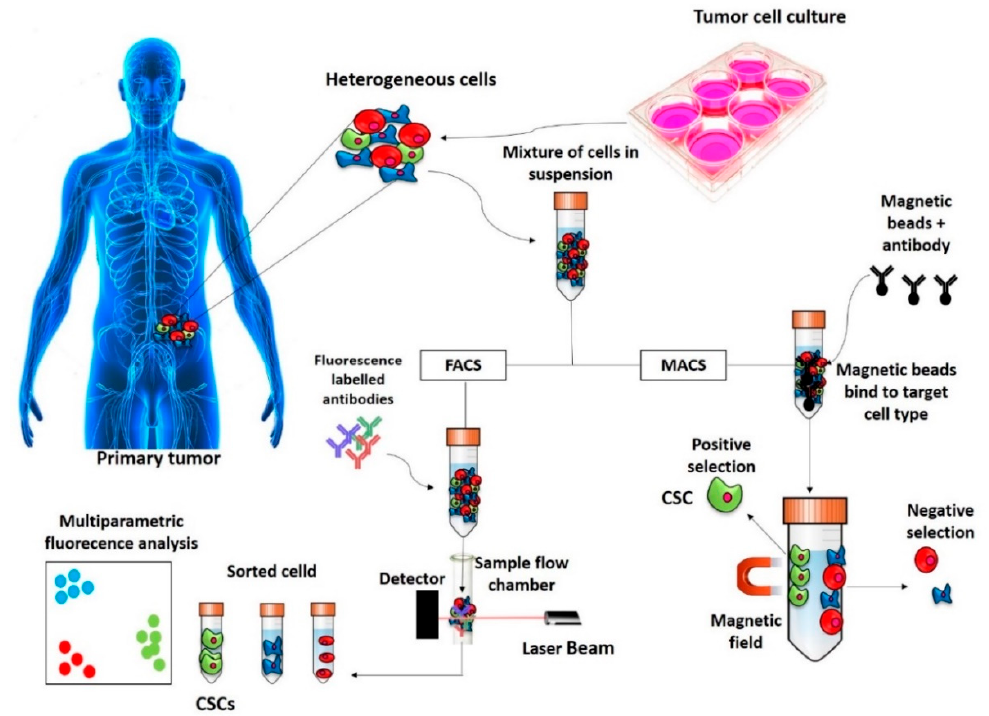
Figure 1. Representation of isolation of CSCs based on surface markers. The CSCs are isolated based on CSC marker expressions by FACS and MACS techniques. CSC—cancer stem cell; FACS—fluorescence-activated cell sorting; MACS—magnetic-activated cell sorting .